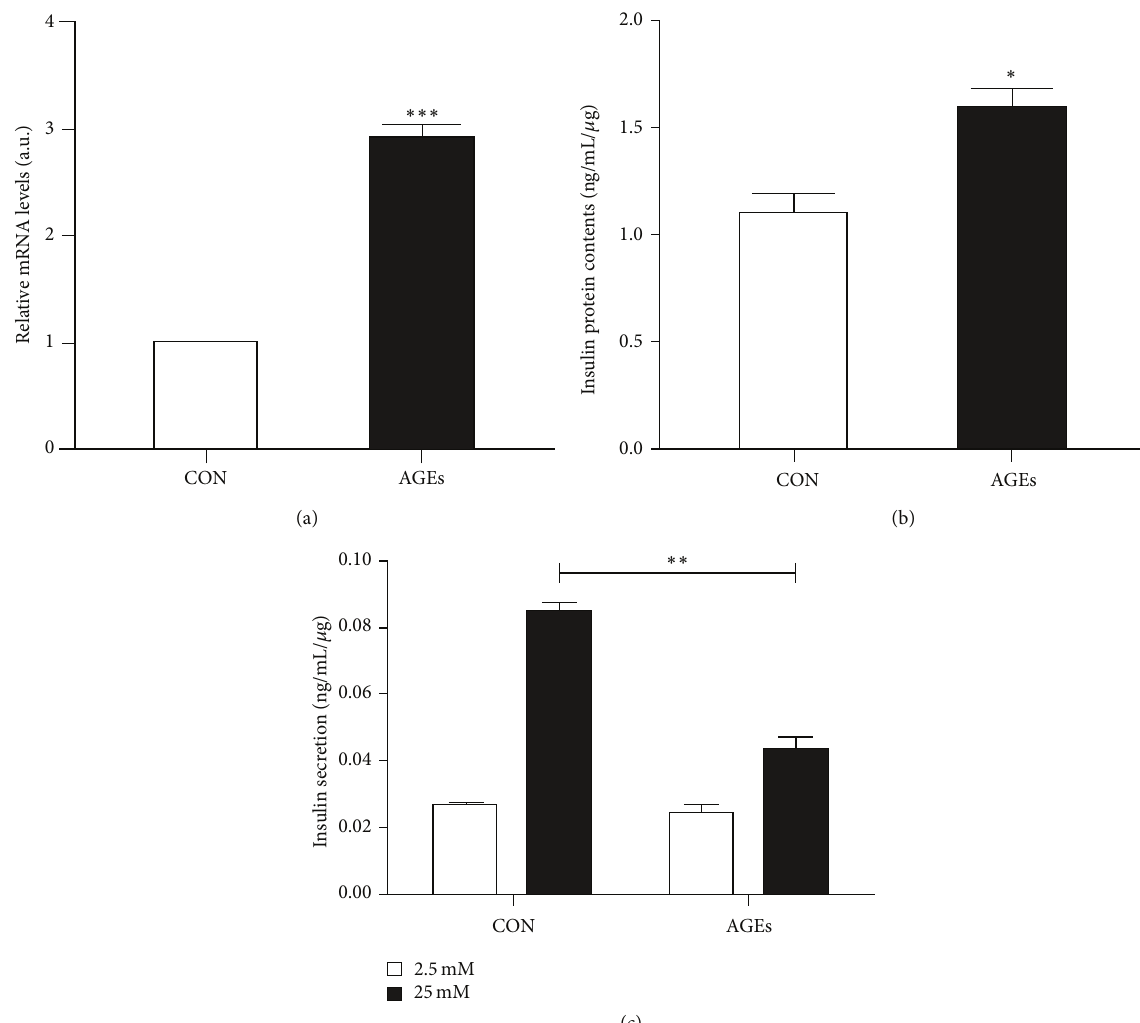
Figure 2: The effect of AGEs on insulin secretion in INS-1-3. (a) The mRNA level of insulin in INS-1-3 cells in the presence or absence of AGEs (200 𝜇 g/mL, 48 hours), measured by real-time PCR. (b) The total intracellular insulin content in INS-1-3 in the presence or absence of AGEs (200 𝜇 g/mL, 48 hours). Insulin was extracted with acid ethanol and quantified by ELISA. (c) Secreted insulin amounts in INS-1-3 cells in response to 2.5 mM and 25 mM glucose. INS-1-3 cells were incubated with or without AGEs (200 𝜇 g/mL) for 48 hours. Secreted insulin levels were normalized to the total insulin content. Data are derived from three independent experiments and shown as mean ± SD. ∗ 𝑝 < 0.05 ; ∗∗ 𝑝 < 0.01 ; ∗∗∗ 𝑝 < 0.001 versus